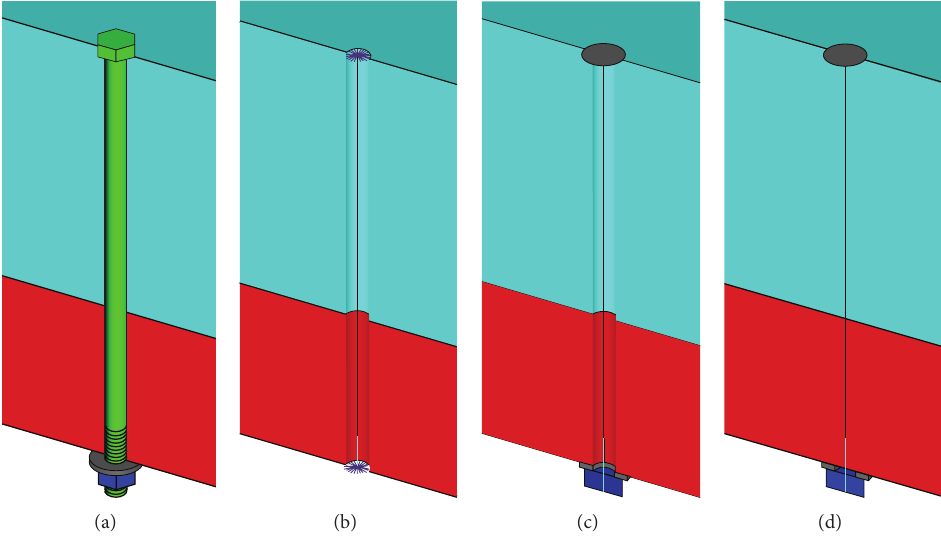
Figure 6: Static tension bolt modeling approaches, including (a) detailed model, (b) simplified model with end linkages (#1–3), (c) simplified model with shell head and embedded end, with a hole (#4), and (d) simplified model with shell head and embedded end, without a hole